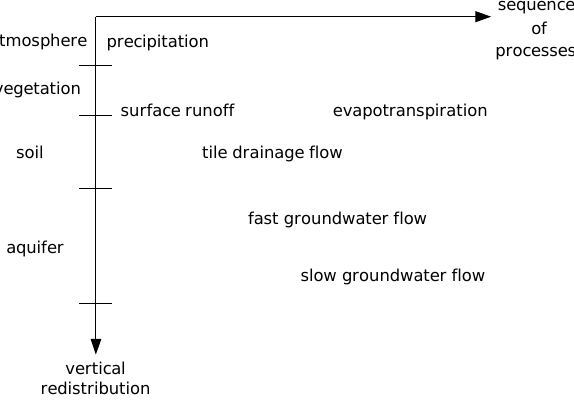
Figure 2. Schema of the timing of processes after a precipitation event based on the concept of vertical water